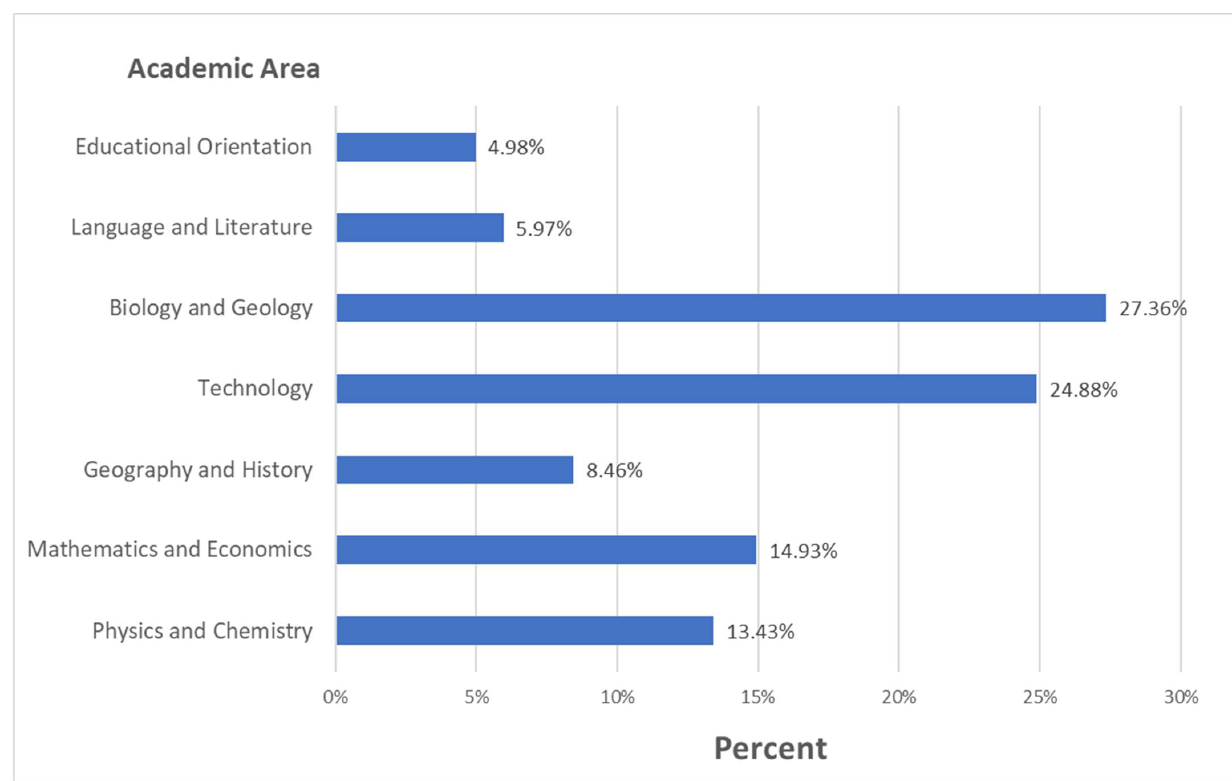
Figure 1. Sample distribution according to age and sex of the participants.